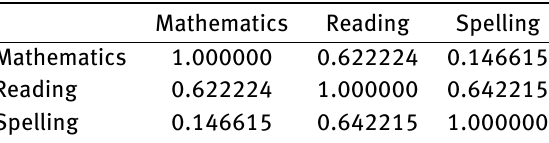
Table 2: Pearson correlation